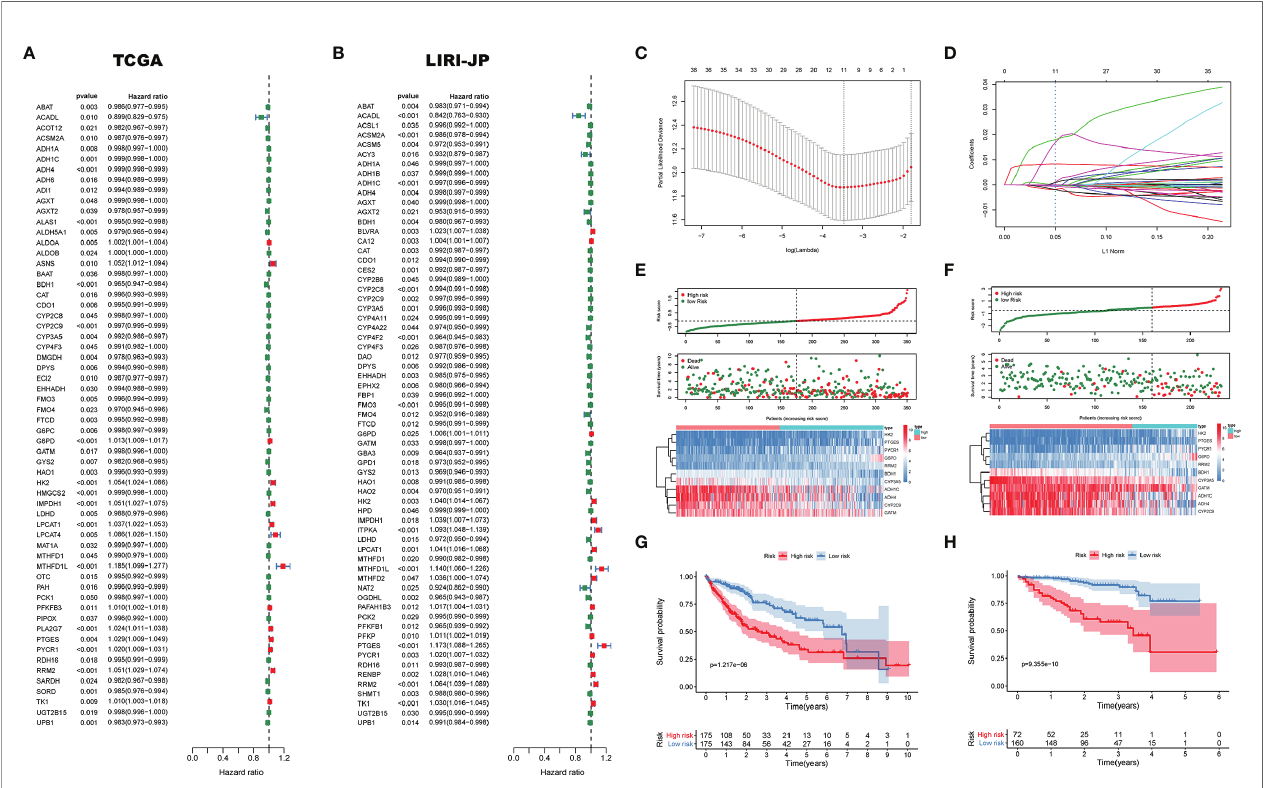
FIGURE 7 | The survival-predictor model based on eleven DEMGs. Univariate Cox analyses showed that 60 DEMGs contributed to the OS in (A) TCGA and (B) LIRI_JP, respectively. (C, D) The LASSO regression model identi fi ed the 11 most accurate predictive DEMGs in TCGA. (E) HCC patients were divided into two groups by the median risk score cutoff point in TCGA: high risk and low risk. (F) According to the same cutoff point, HCC patients were also divided into two groups in LIRI_JP; Kaplan – Meier Survival analysis results indicated that the two groups had signi fi cantly different survival rates in both (G) TCGA (log-rank test p -value = 1.217e − 06) and (H) LIRI_JP (log-rank test p -value = 9.355e − 10). DEMGs, differentially expressed metabolic genes; HCC, hepatocellular